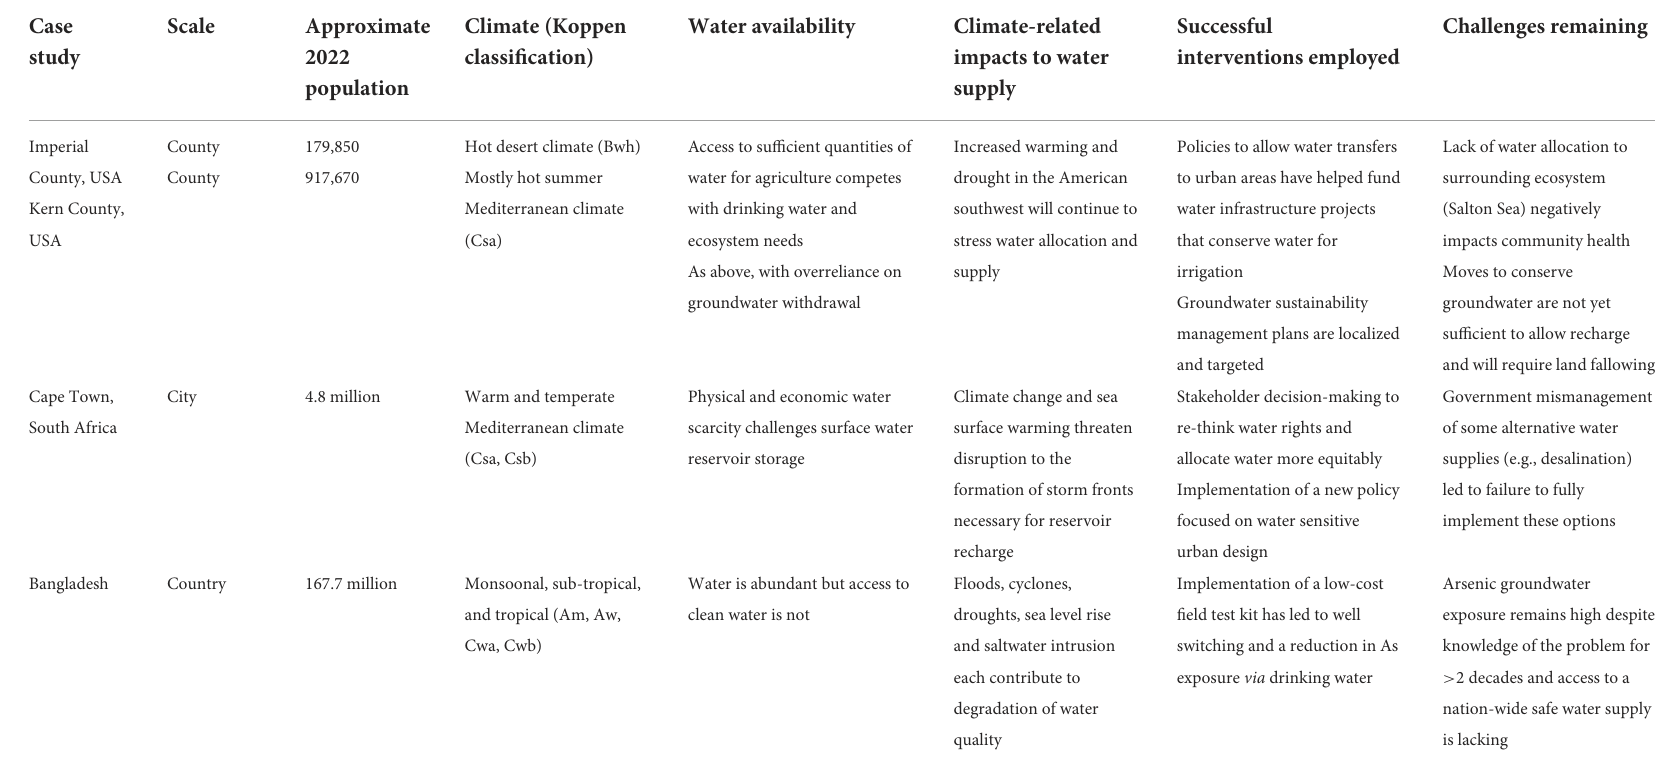
TABLE 1 Synthesis and comparison of three water-challenged